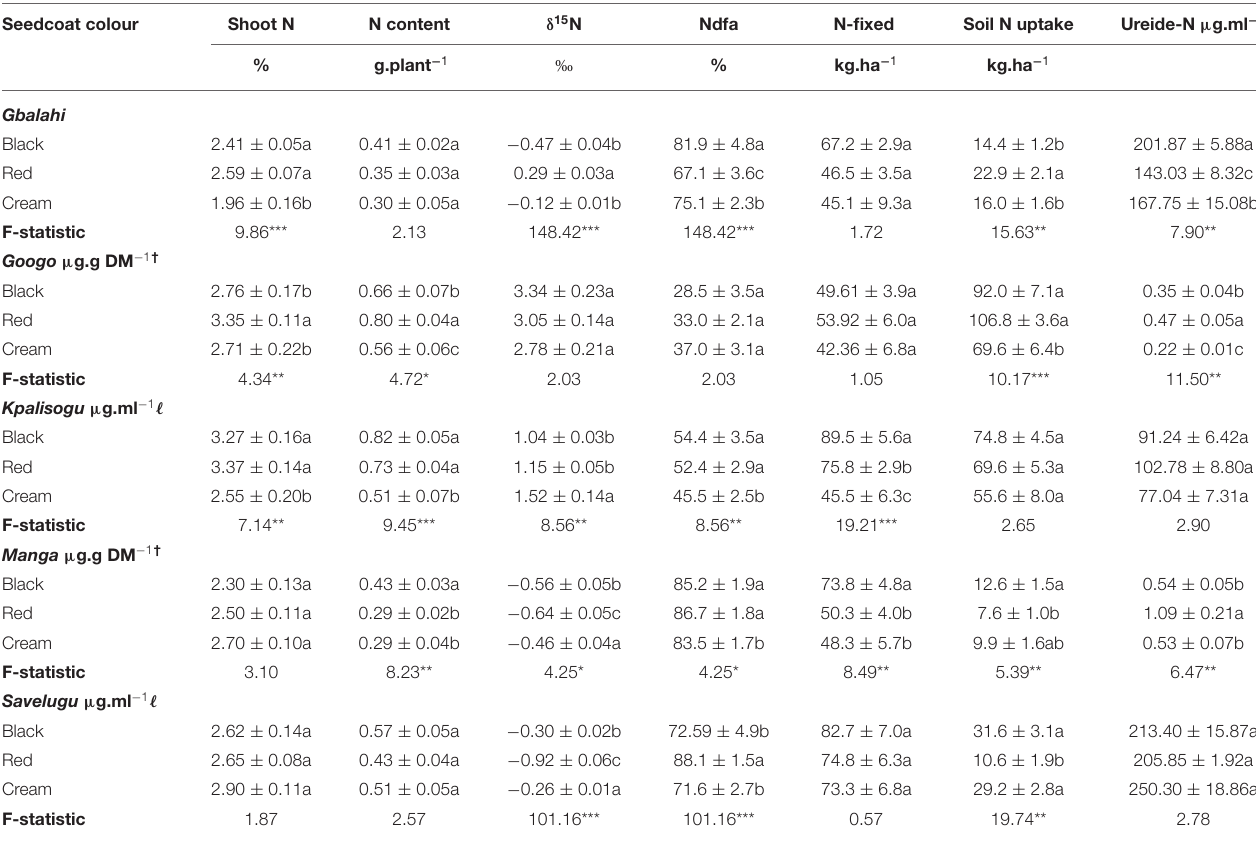
TABLE 5 | Shoot N concentration, N-fixed, ureide concentration and soil N uptake of Bambara groundnut landraces with different seedcoat colours sampled at flowering from five sites in Ghana. Seedcoat colour